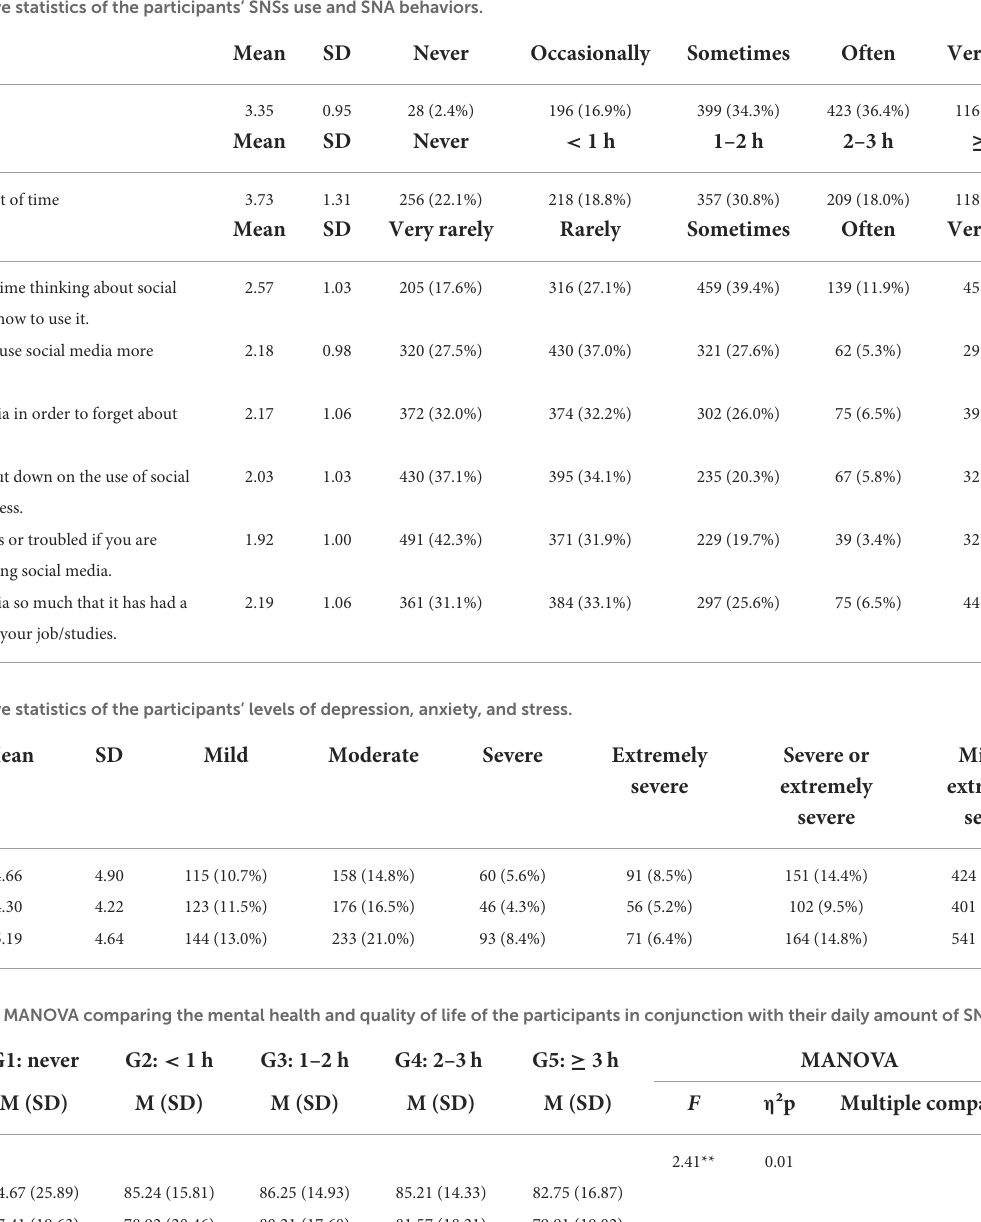
TABLE 1 Descriptive statistics of the participants’ SNSs use and SNA behaviors. Variable